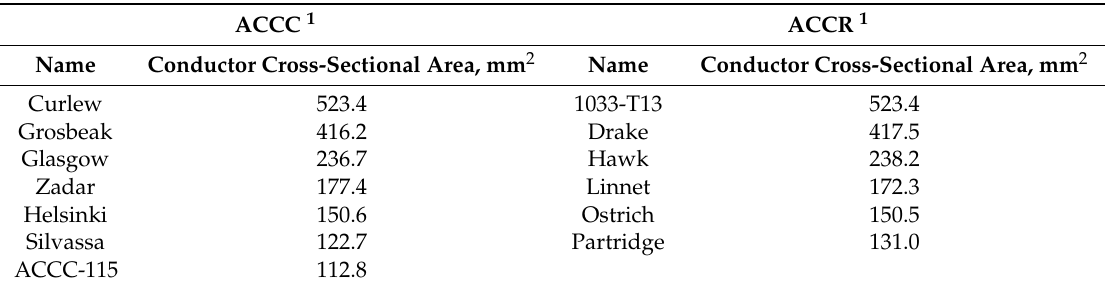
Figure 10. Conductor configurations of ( a ) aluminum conductor composite reinforced (ACCR) type [51] and ( b ) aluminum conductor composite core (ACCC) type [52]. Table 8. Cross-sectional areas of examined aluminum conductor composite core (ACCC) types and aluminum conductor composite reinforced (ACCR) types for both